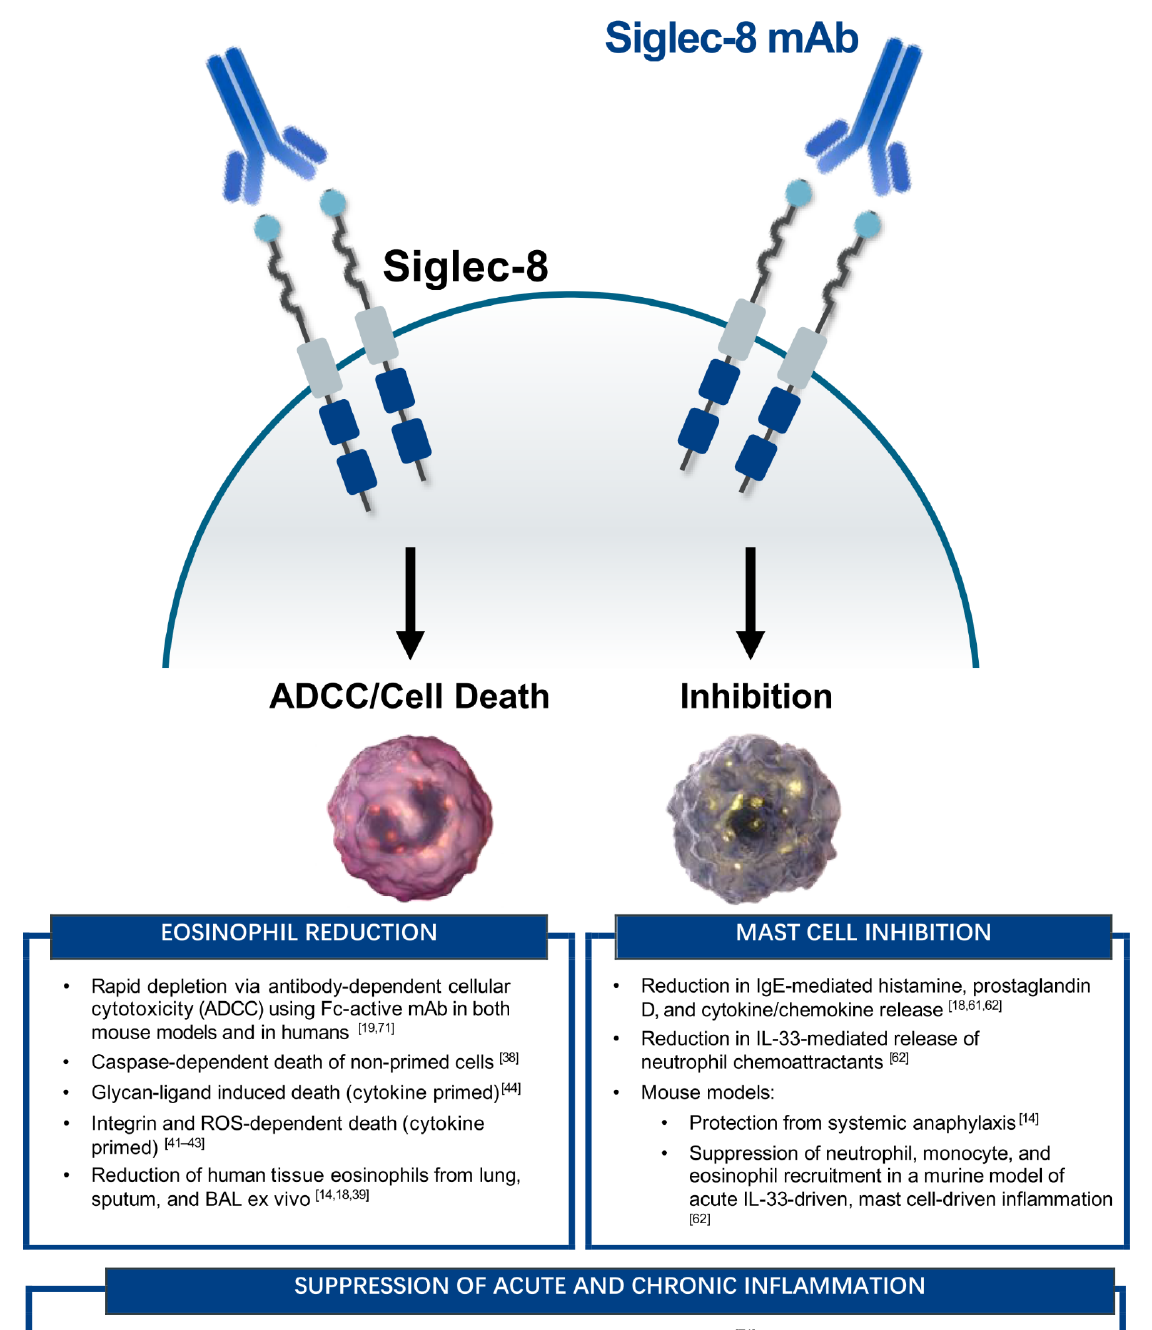
Figure 1. Summary of the in vitro and in vivo functions of Siglec-8 on eosinophils and mast cells. ( Left ) Eosinophil-specific activity of Siglec-8 mAbs or glycan-ligands. ( Right ) Mast cell-specific activity of Siglec-8 mAbs. ( Bottom ) Anti-inflammatory activity of targeting both eosinophils and mast cells with Siglec-8 mAbs. ADCC, antibody-dependent cellular cytotoxicity; AKC, atopic keratoconjunctivitis; CSU, chronic spontaneous urticaria; EG/EoD, eosinophilic gastritis/eosinophilic duodenitis; ISM, indolent systemic mastocytosis.